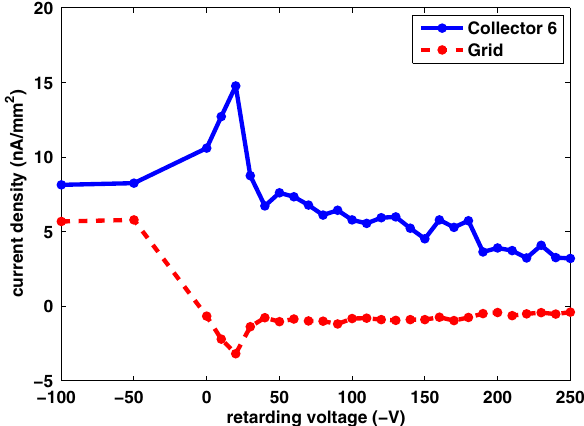
FIG. 15. POSINST simulation showing resonant enhancement in a wiggler RFA, 1 × 45 × 1 . 2 mA e þ , 2.1 GeV, 14 ns, central collector. Compare to Fig.